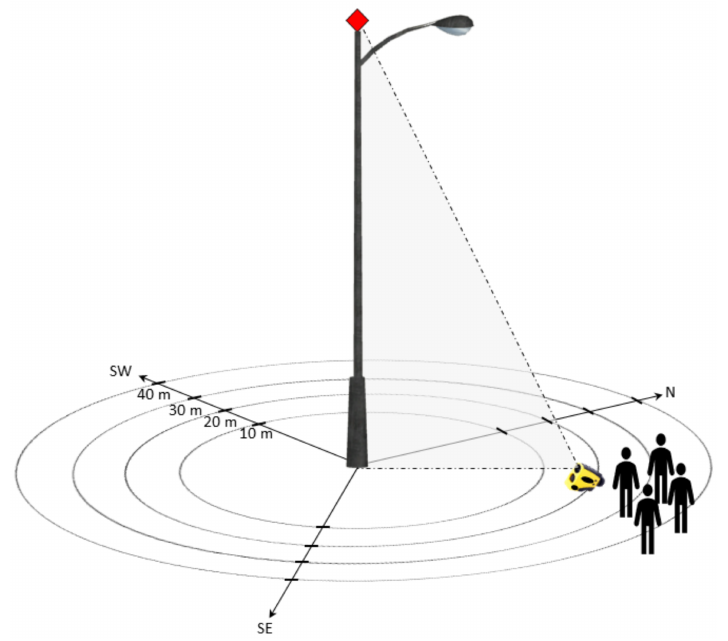
Figure 2. Experimental design adopted in this work involving four operators. Three geographical direction placed at 120 ◦ apart were used pointing to the: North, South-East, and South-West. For each position, 3 replicas were measured. Red rhombus is the pole top collimated during the height survey placed at 10 m, 20 m, 30 m, and 40 m distance,